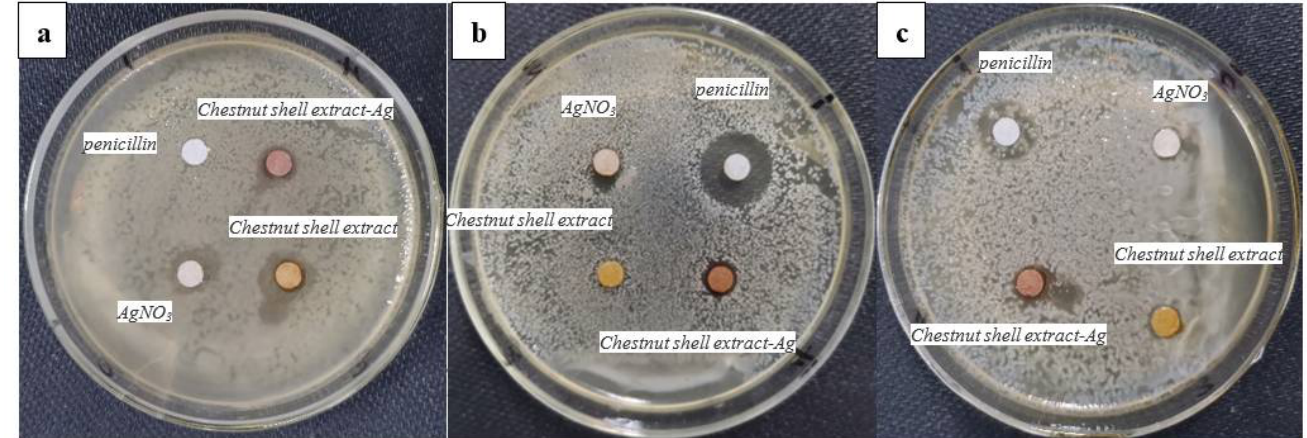
Figure 5. The photograph of the zone of inhibition of the functionalized chestnut-shell-extract Ag nanoparticles, the chestnut shell extract, AgNO 3 solution and penicillin against ( a ) Escherichia coli ( b ) Candida albicans ( c ) Staphylococcus aureus.